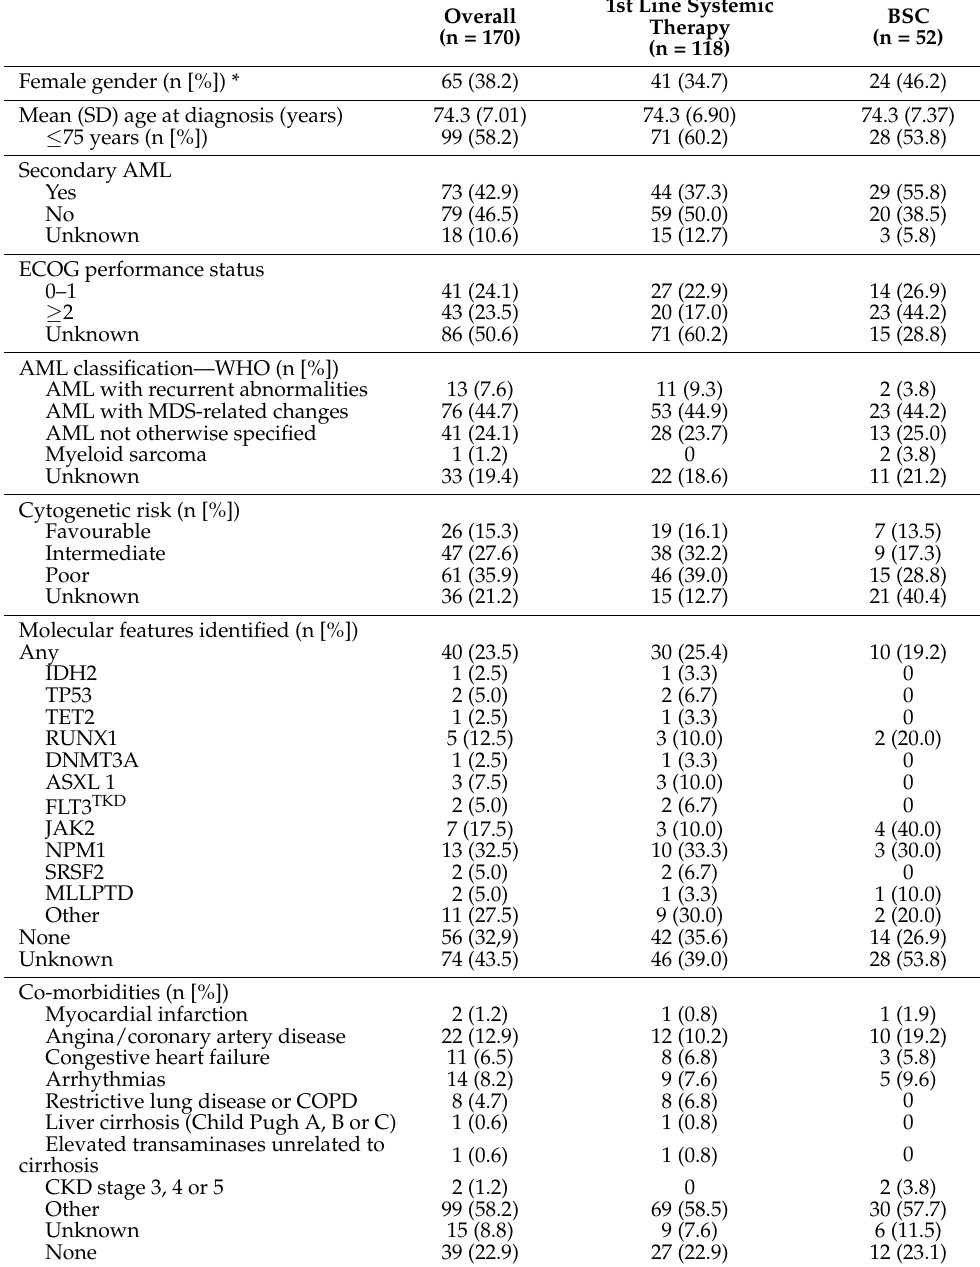
Table 1. Patient demographics and baseline